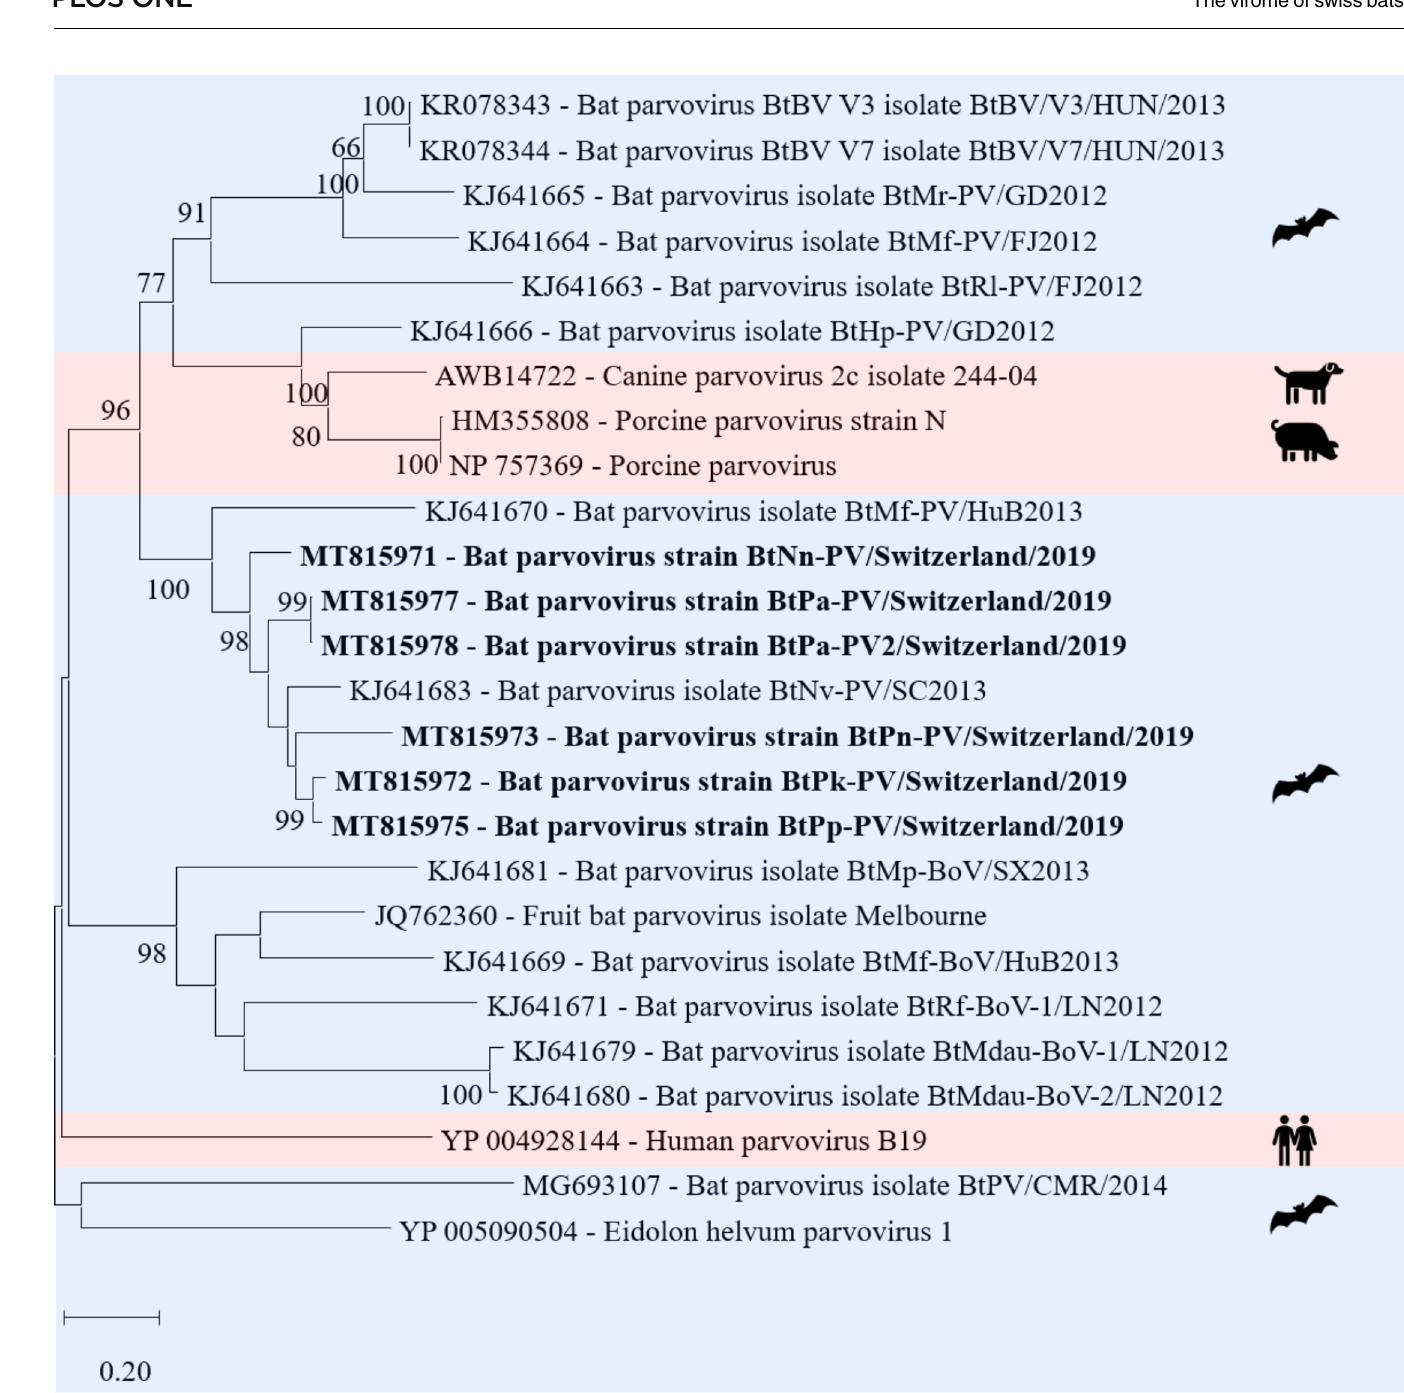
Fig 9. Phylogenetic analysis of the NS1 region of parvoviruses. The sequences obtained in this study (GenBank acc. numbers MT815971-73, MT815975, 77, 78) are shown in bold. Sequences of non-bat associated viruses are marked with a red background and those of bat associated viruses with a blue background. The pictograms on the right side represent the species in which the virus was detected. Sequences were aligned using Muscle. For phylogenetic analysis, the Maximum likelihood tree with 1’000 bootstraps was used. Only values � 70% are displayed.